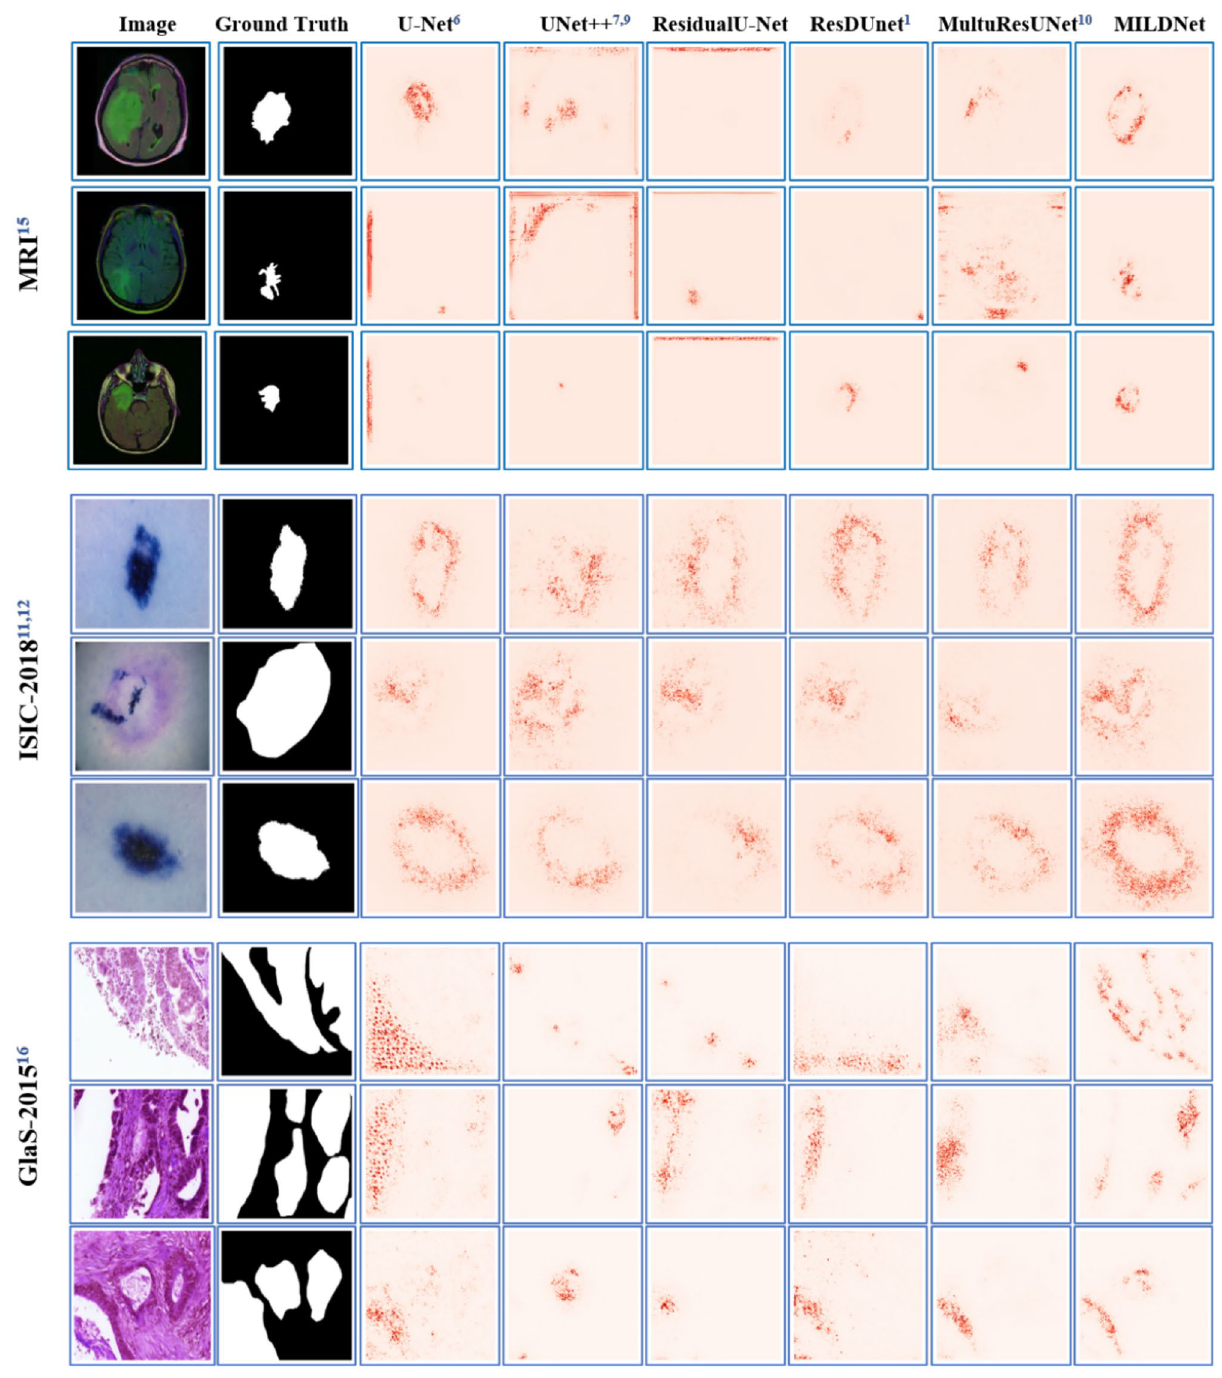
Figure 7. Saliency maps for the MRI, the dermoscopy, and the histopathology examples. Regions that have a high impact on the models’ final decision are